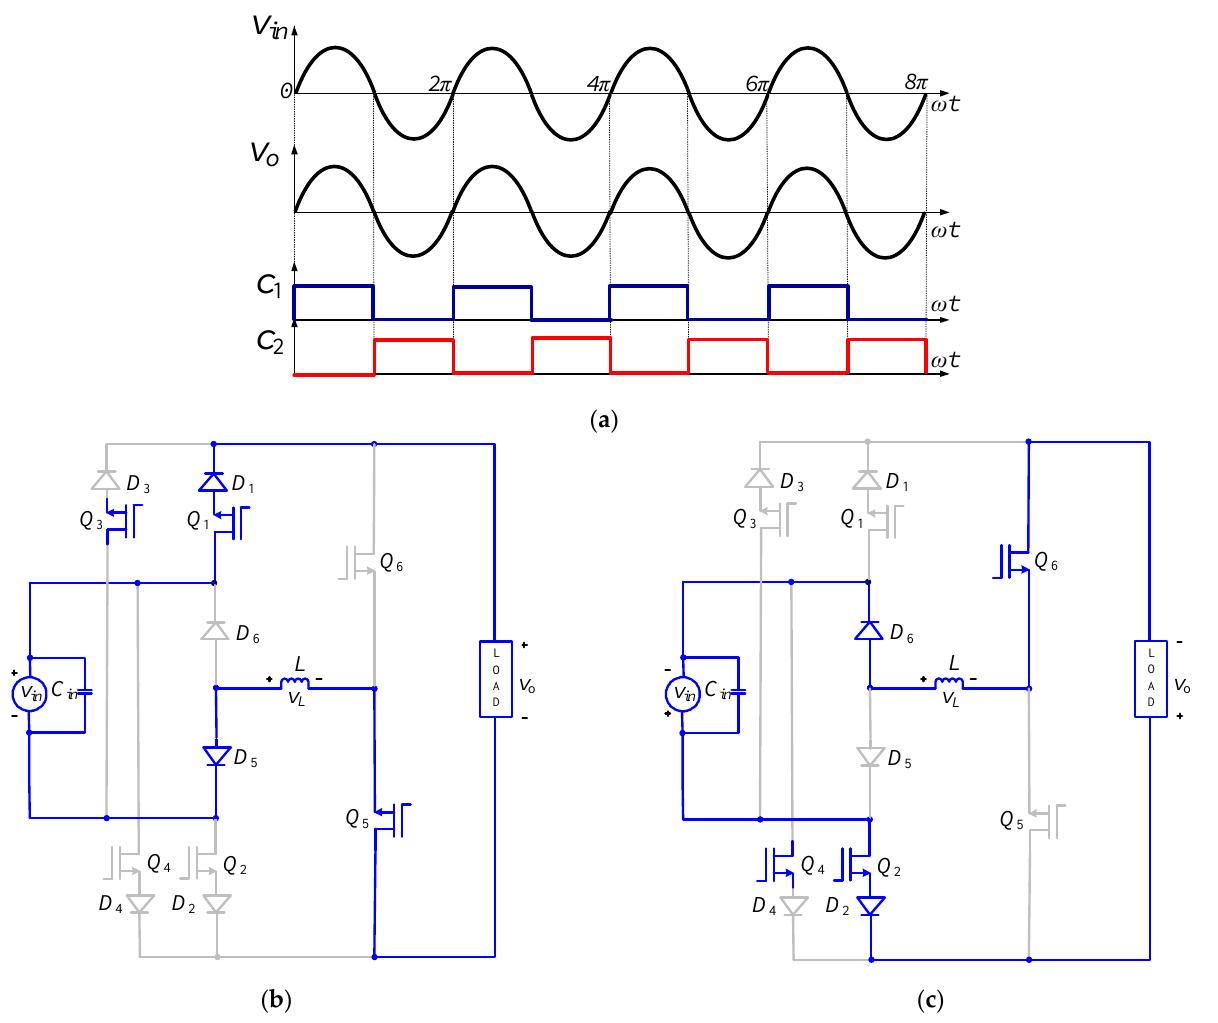
Figure 5. Voltage non-inverting operation: ( a ) switching control scheme; ( b ) current closed-loop during positive input; ( c ) current closed-loop during negative input.